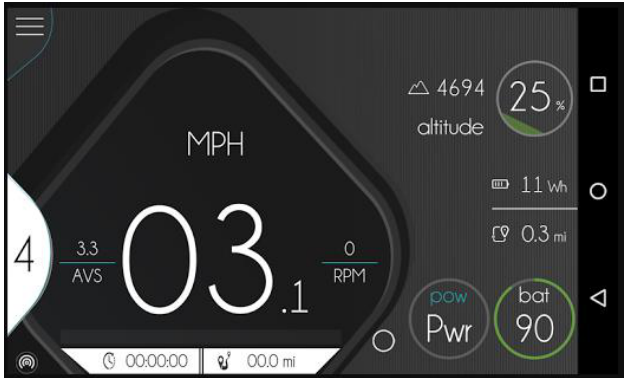
Figure 4. Screenshot of ebikemotion app.